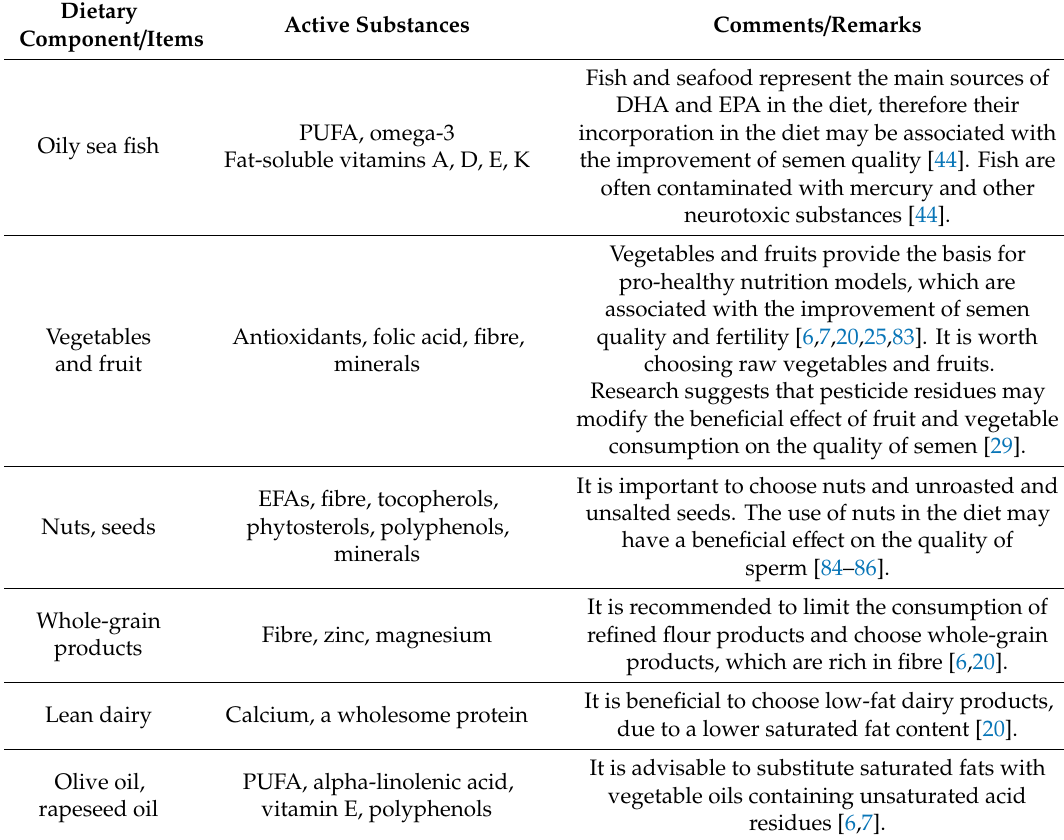
Table 1. Characteristics of a diet beneficial for